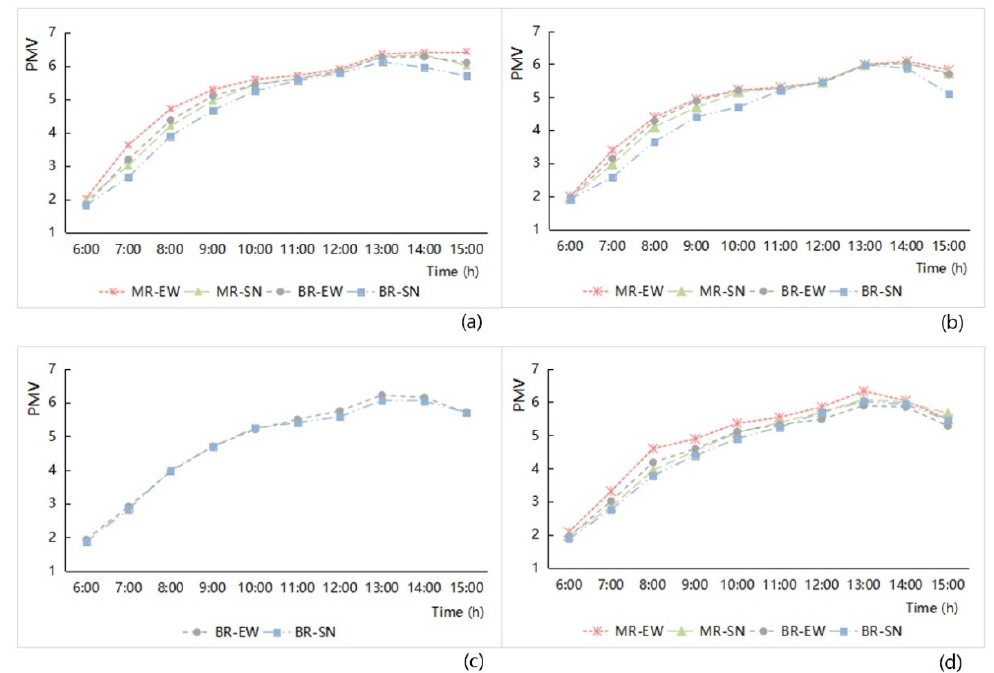
Figure 11. Hourly Predicted Mean Vote (PMV) variation analysis related to the different grade width and orientation of street space from 6:00 to 15:00 in the four study areas (( a ) Old downtown; ( b ) Gubei international community; ( c ) Anting New Town; ( d ) New Jiangwan Town).